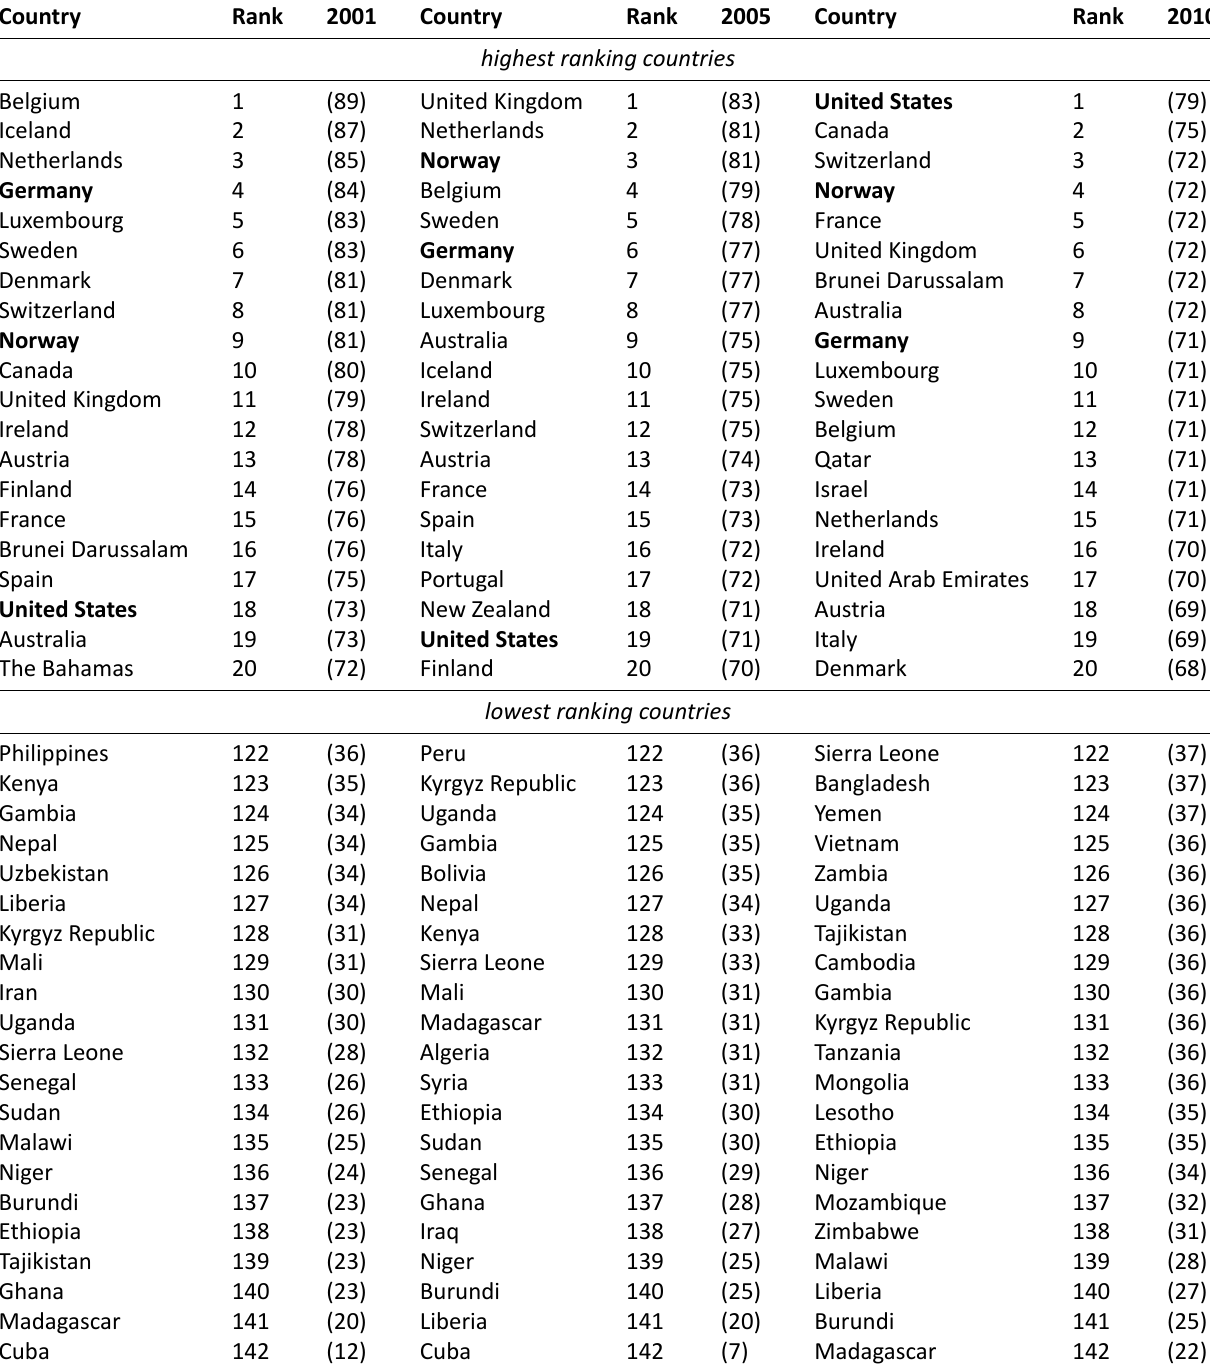
Table 4. Highest and lowest ranking countries in specific years.